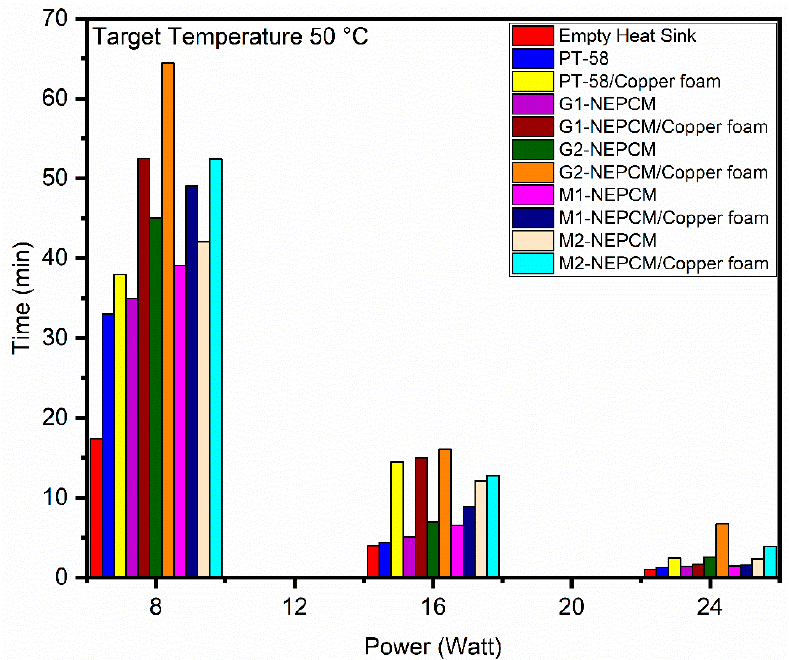
Figure 19. Time to attain target temperature of 50 ℃ for heat sink filled with PCM, NEPCM and NEPCM/copper foam composites.